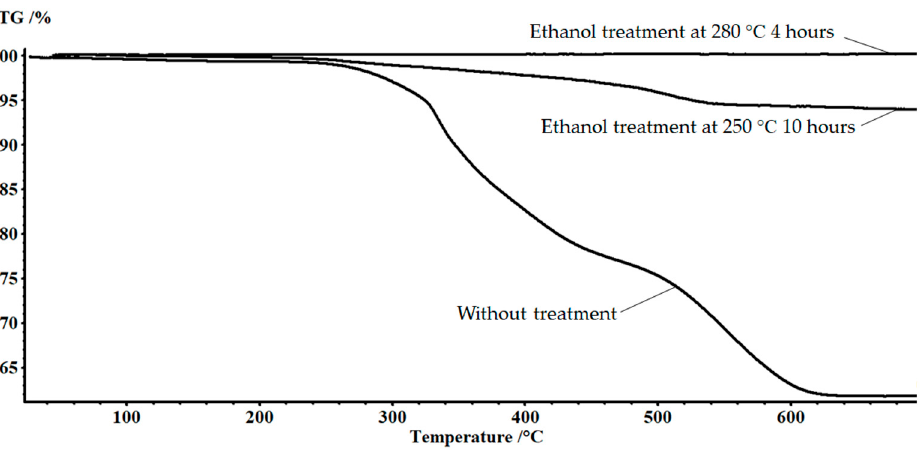
Figure 3. TG curves of FGRP samples.